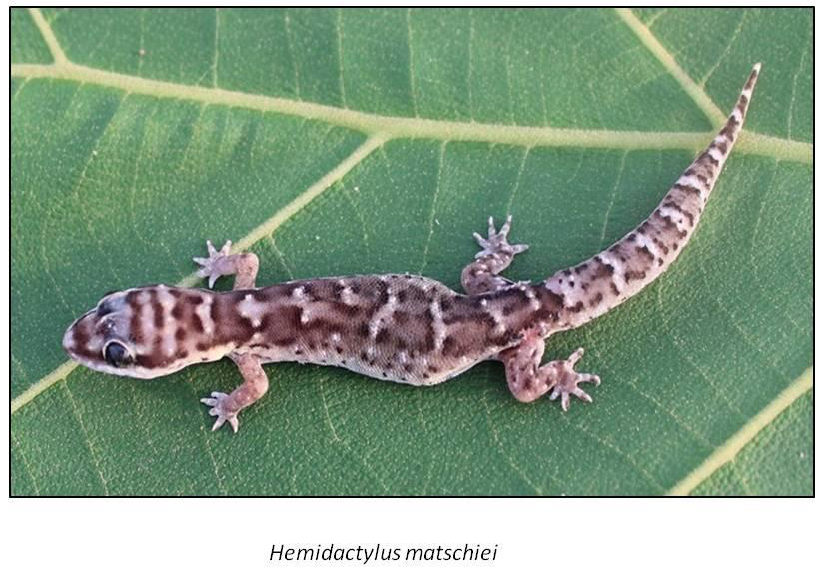
Figure 5. Hemidactylus matschiei , a rare gekko species that is known to occur only in Togo and Nigeria. Our records considerably extend their known distribution within Togo.